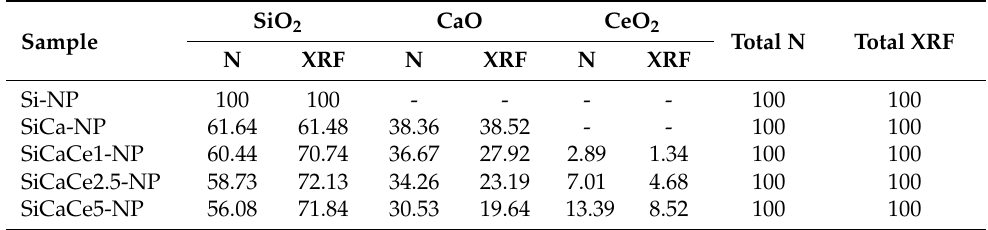
Table 3. Chemical composition of the synthesized MSNs as detected using XRF in